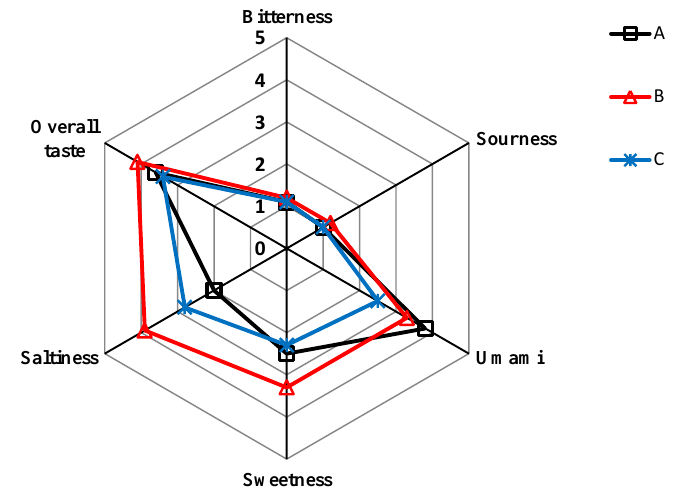
Figure 4. Sensory analysis result of SPHSS (A), SPH (B) and MRPH (C).